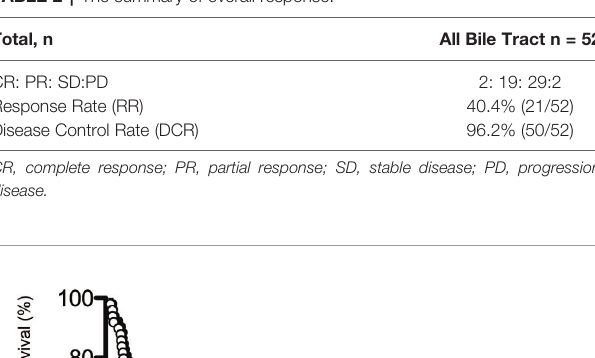
TABLE 2 | The summary of overall response.